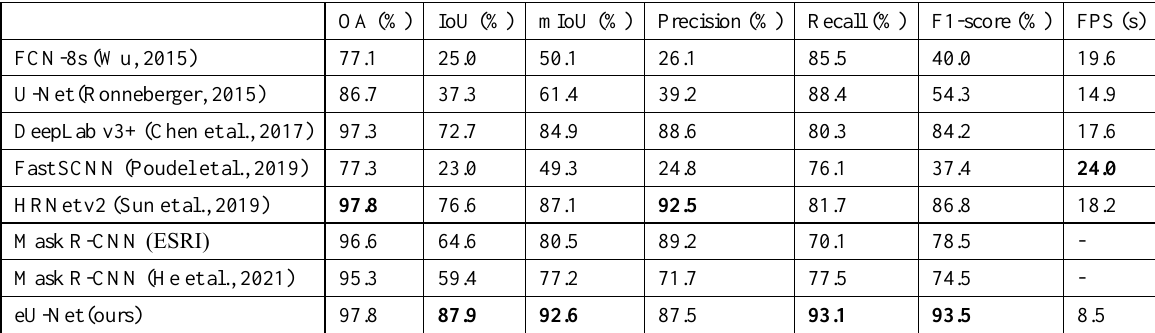
Table 3. Results of comparison